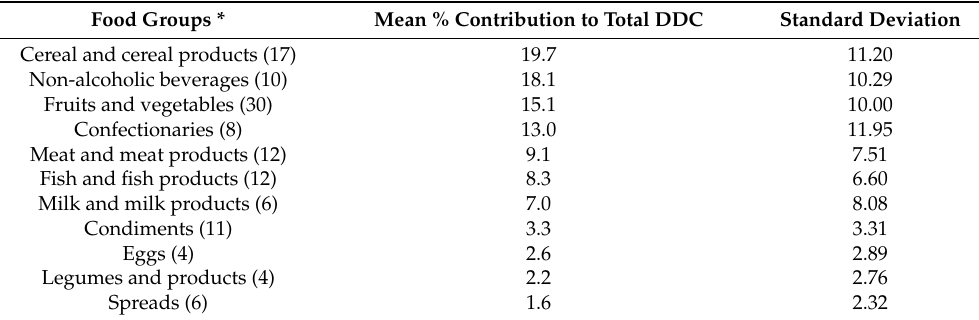
Table 2. Percentage of food group intakes contributing to total